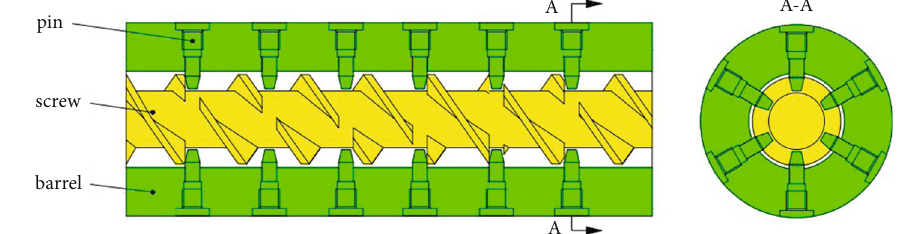
Figure 1: Pin barrel